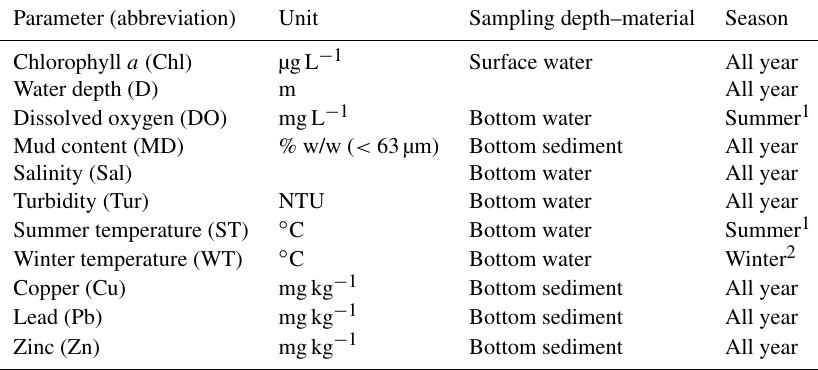
Table 1. Summary of marine water–sediment